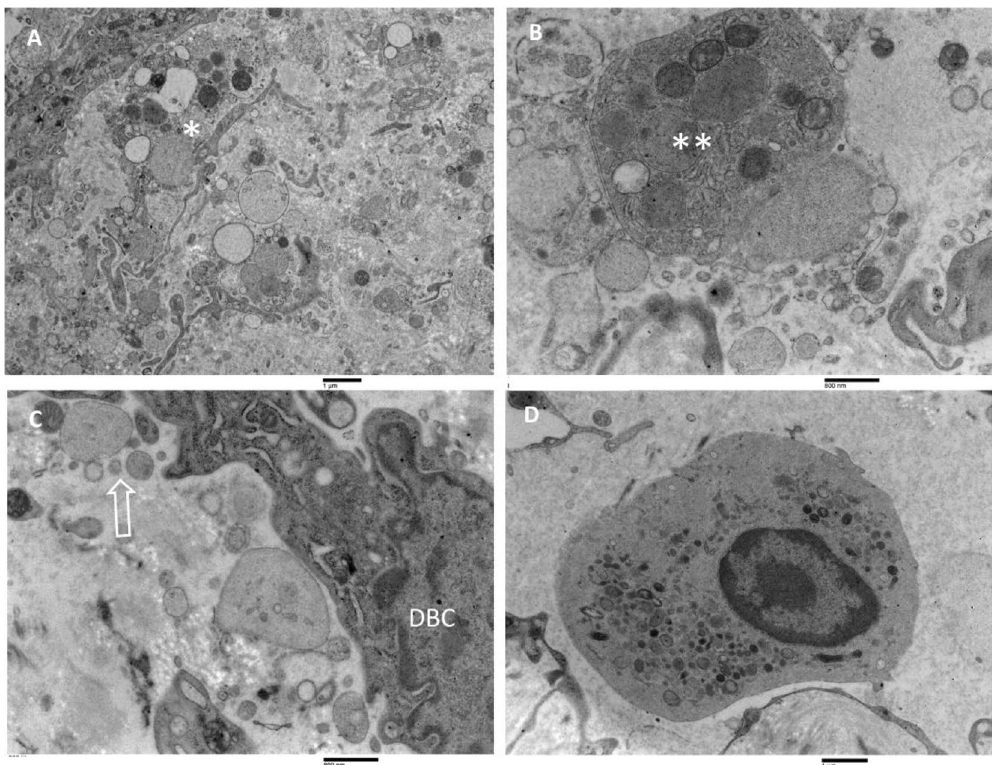
Figure 11. Transmission electron microscopy of the CSDH inner membrane. ( A – C ) In the extracellular matrix, a loose network of collagen fibres and a presence of disintegrating cells (asterisk), apoptotic bodies (double asterisks), various-sized microvesicles, and exosomes (arrow). DBC = dural border cells. ( A ) 14,000 ×, bar = 1 µm; ( B , C ) 24,800 ×, bar = 800 nm. ( D ) a macrophage in the extracellular matrix. 16,800 ×, bar = 1